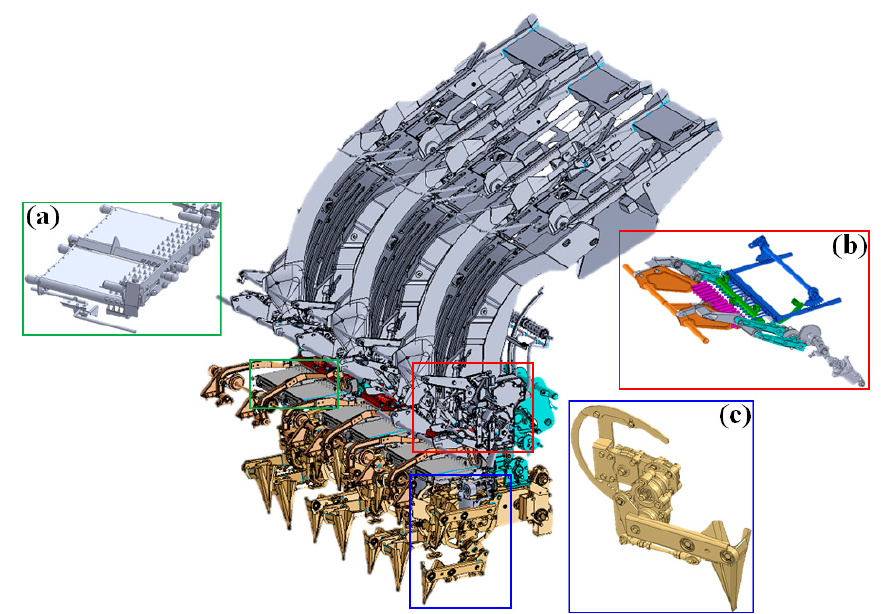
Figure 1. Schematic view of the onion transplanting mechanism assembly: ( a ) conveyor mechanism, ( b ) picking mechanism, and ( c ) rotary planting mechanism.